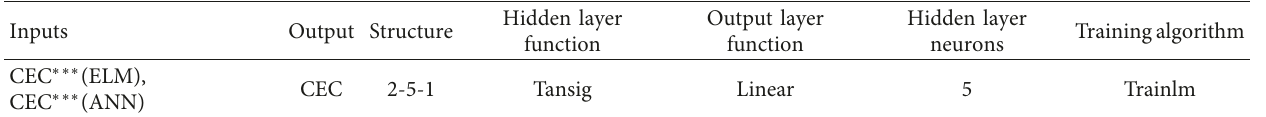
Table 7: ANN Parameters of the best MM-GANN